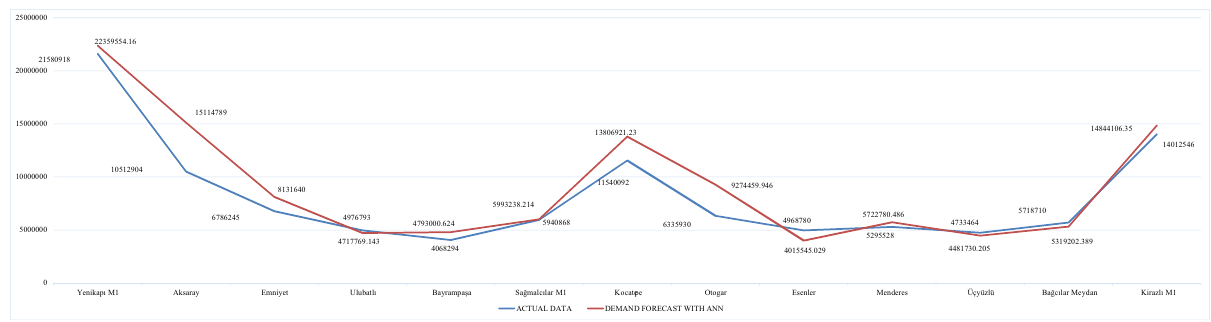
Figure 7: Comparison of actual data and demand forecast with ANNs on station basis.